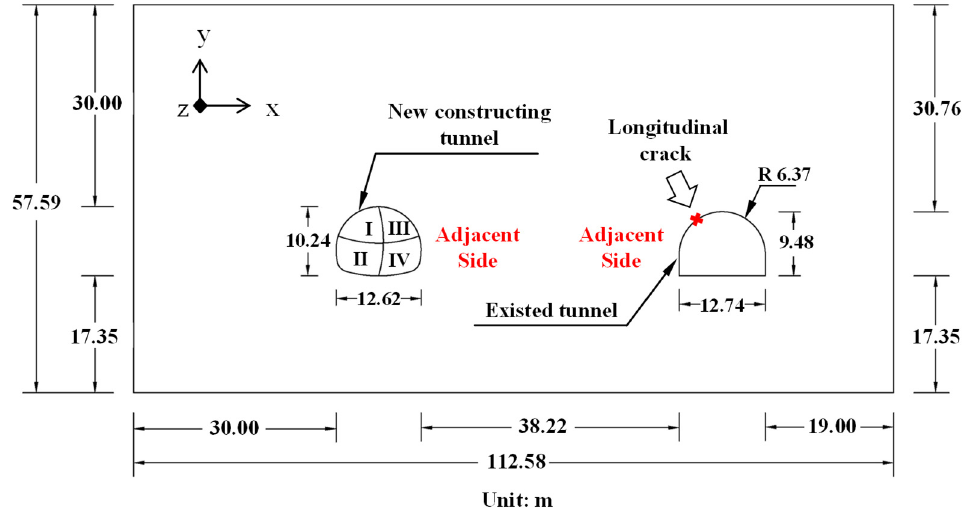
Figure 4. Cross ‐ sectional diagram of rock mass model. Figure 4. Cross-sectional diagram of rock mass model.